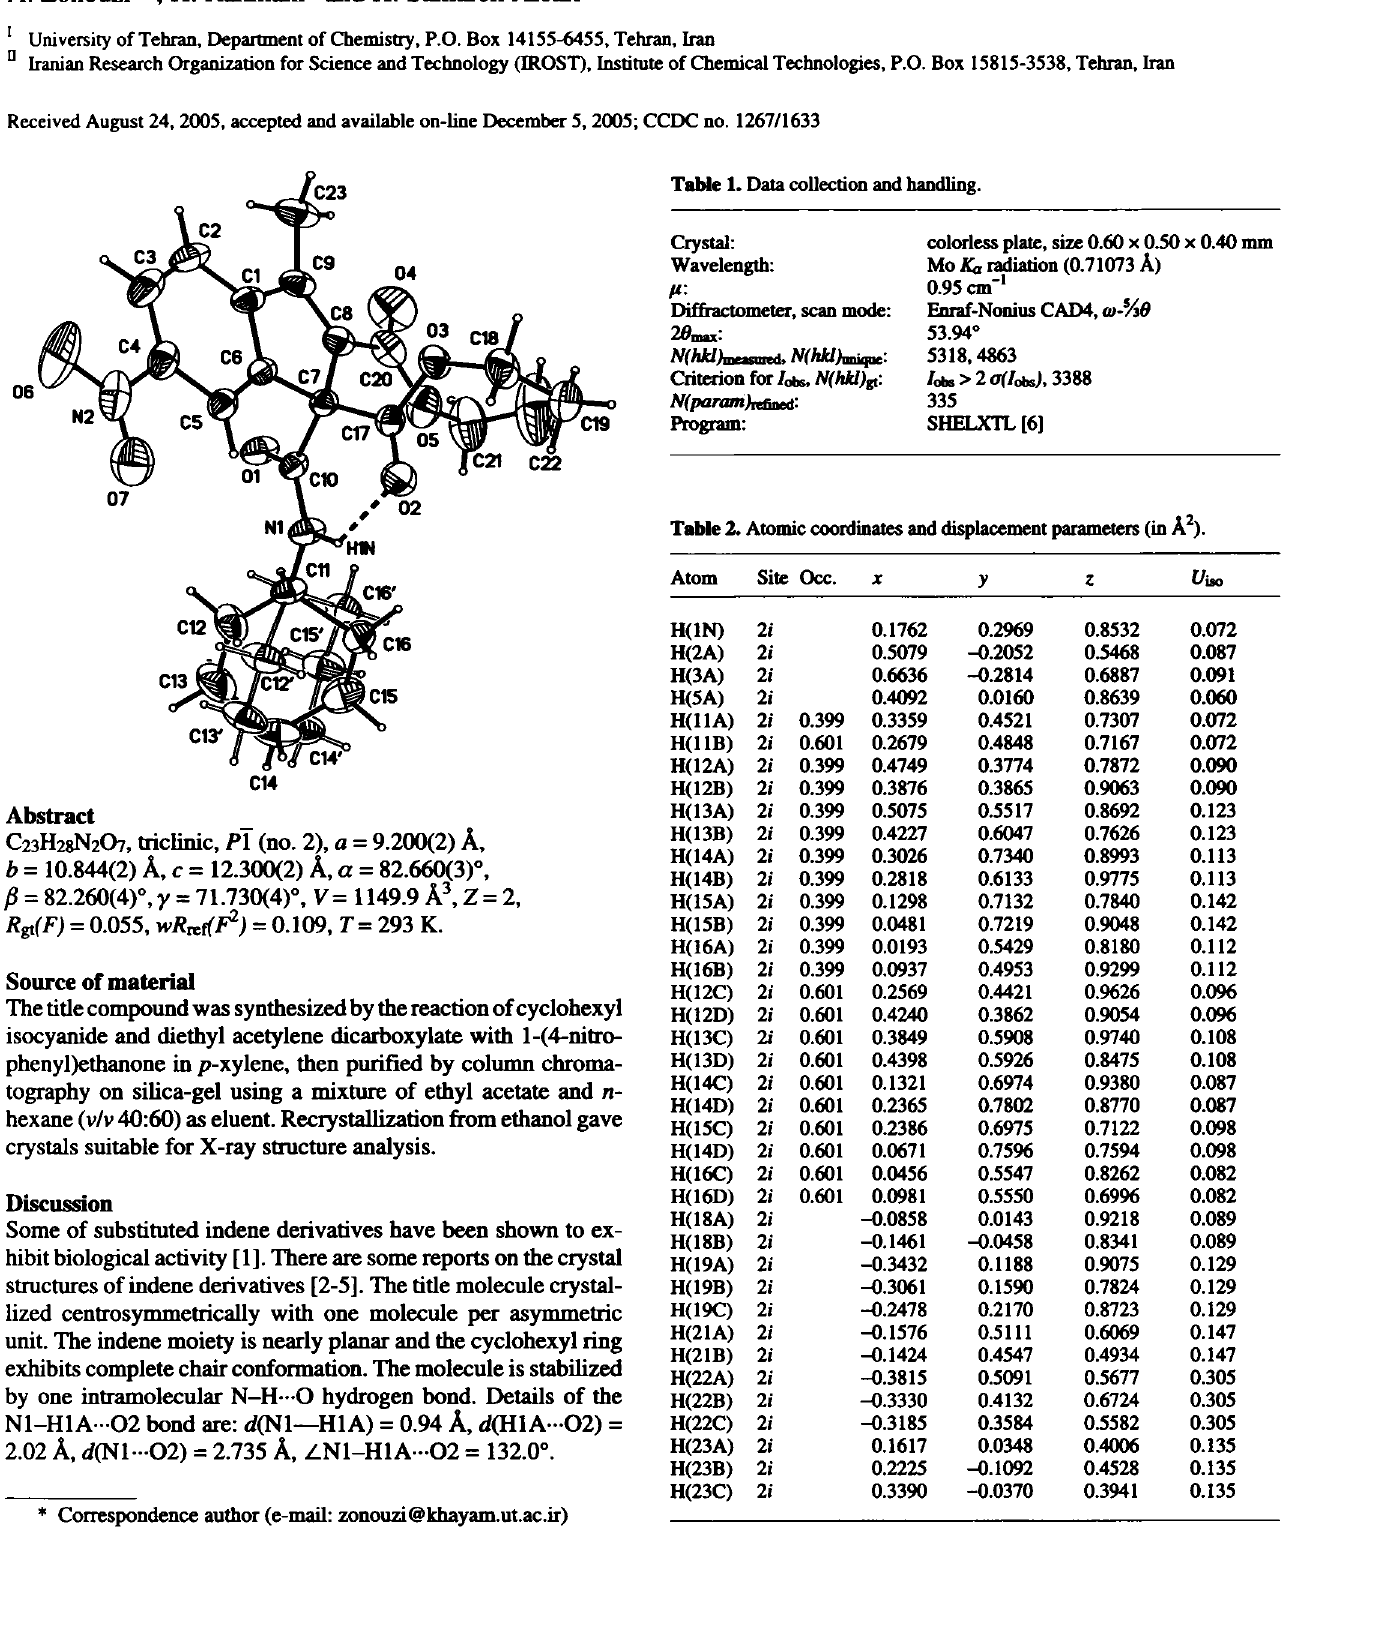
Table 1. Data collection and handling.